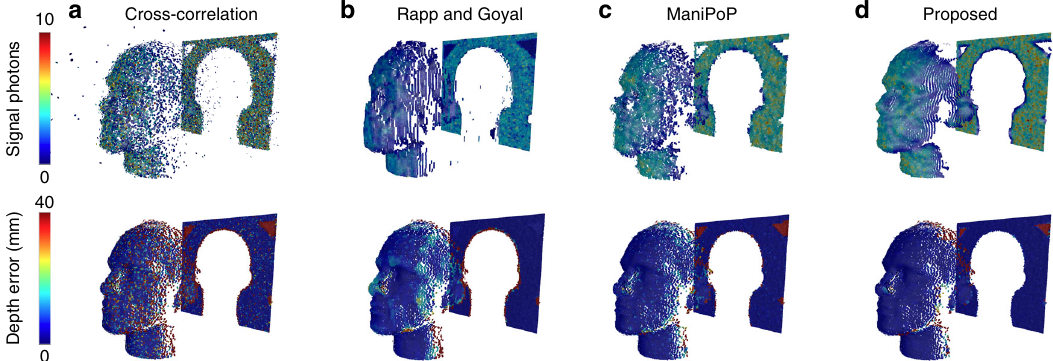
Fig. 3 Comparison of 3D reconstruction methods. Reconstruction results of a cross-correlation, b Rapp and Goyal 16 , c ManiPoP 20 and d the proposed method. The colour bar scale depicts the number of returned photons from the target assigned to each 3D point. Cross-correlation does not include any regularisation, yielding noisy estimates, whereas the results of Rapp and Goyal, ManiPoP and the proposed method show structured point clouds. The method of Rapp and Goyal correlates the borders of the polystyrene head and the backplane (as it assumes a single surface per pixel), whereas ManiPoP and the proposed method do not promote correlations between them